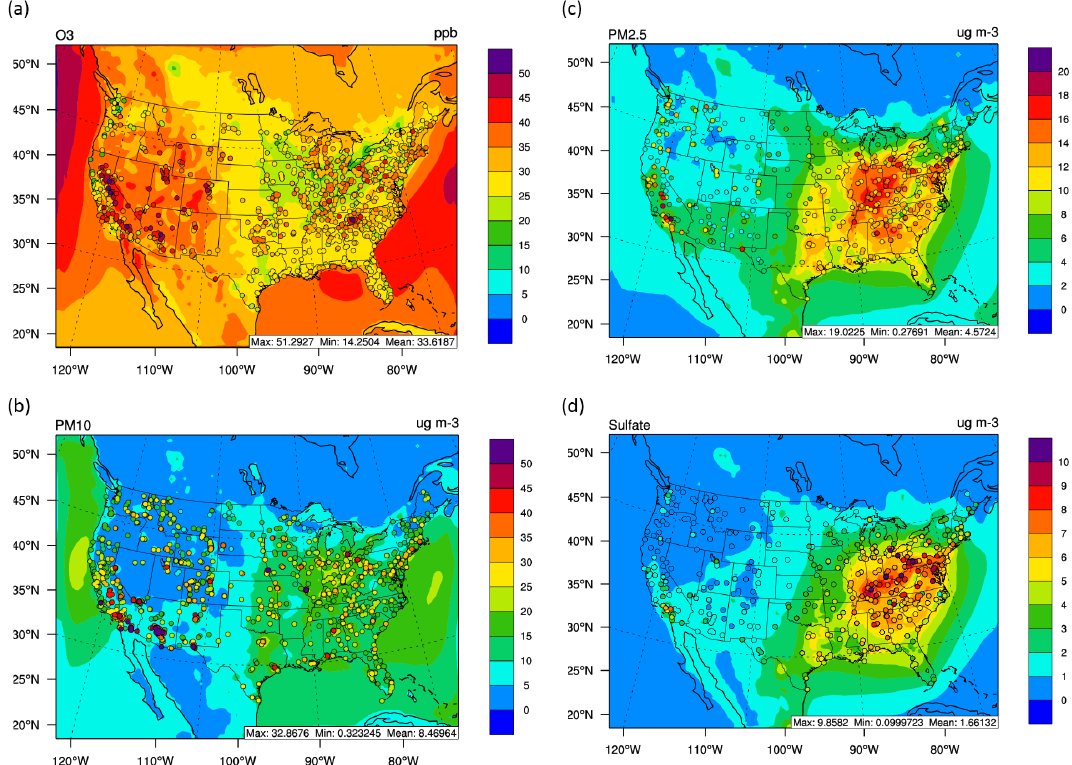
Figure 7. Spatial distribution of 10-year averaged hourly observed vs. simulated (a) O 3 for CASTNET and AIRS-AQS, (b) PM 10 from AIRS- AQS, (c) PM 2 . 5 , and (d) PM 2 . 5 sulfate from STN and IMPROVE. The background plots represent the simulated data, while observations are represented by the